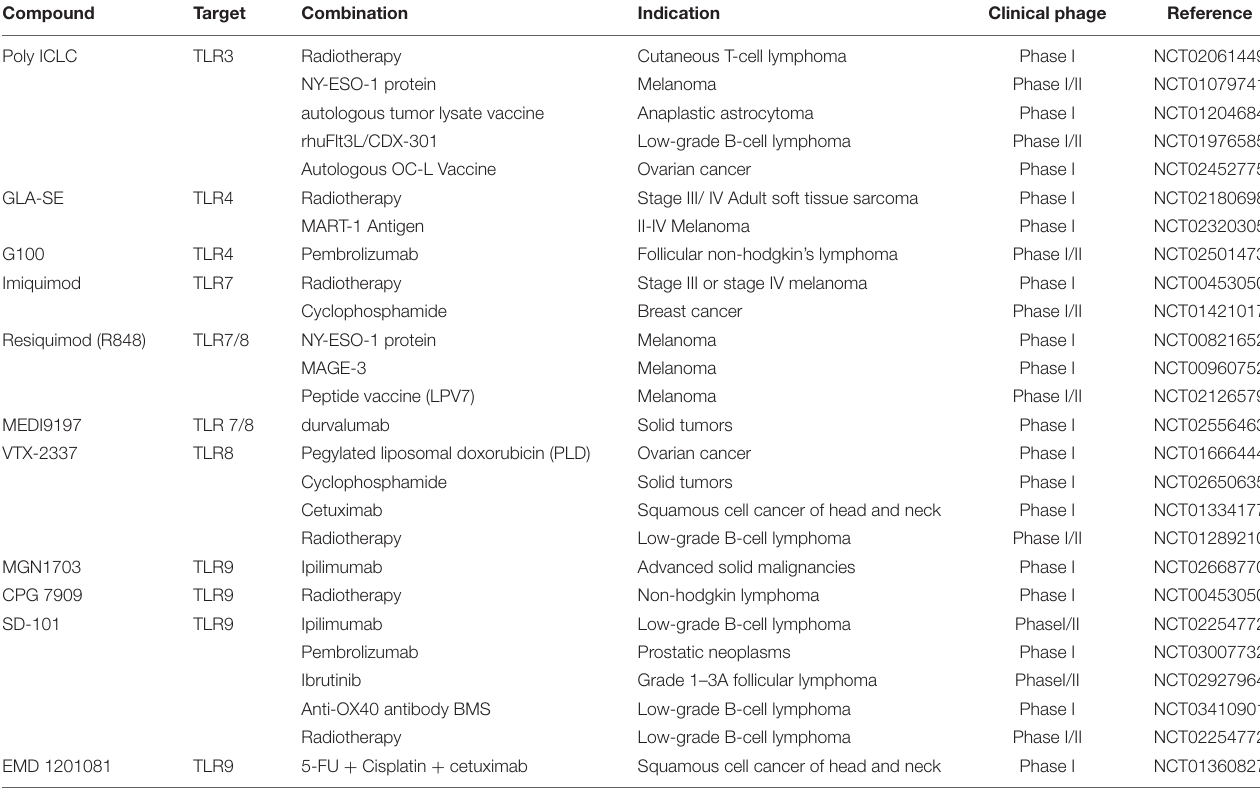
TABLE 1 | Ongoing clinical study of TLRs agonists in cancer treatment as adjuvant.